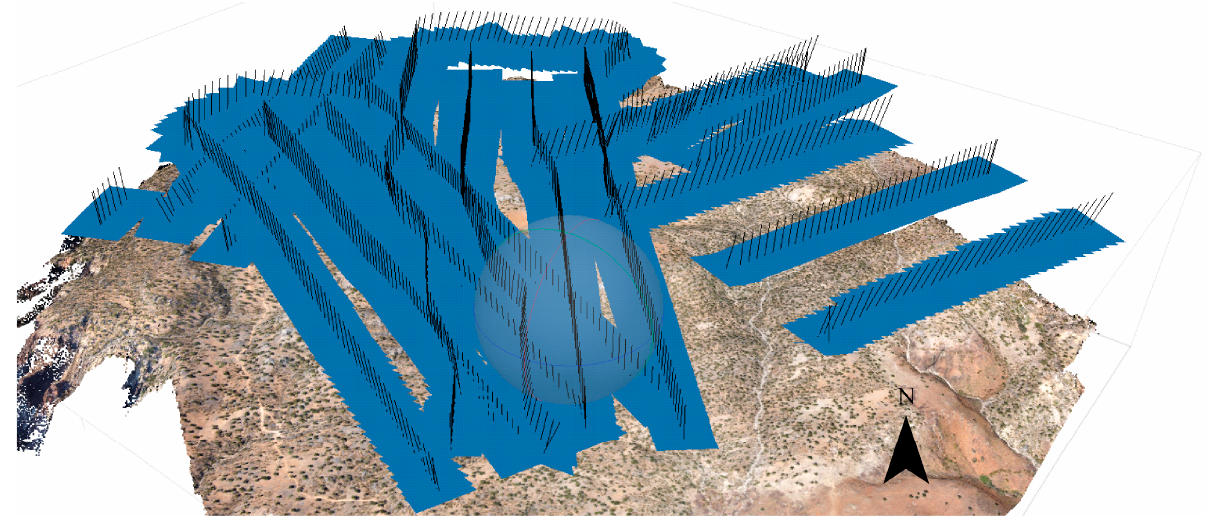
Figure 2. Individual UAV flight trajectories (Firmihin Plateau, Socotra Island, March 2021).